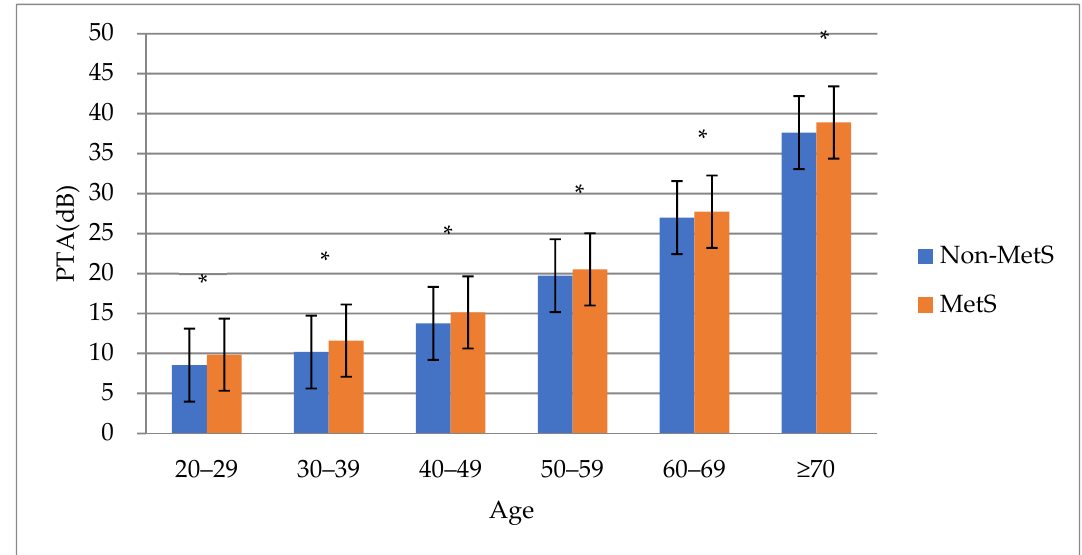
Figure 1. PTA threshold according to age. Abbreviations: MetS, metabolic syndrome; Non–MetS, without metabolic syndrome; PTA, pure tone audiometry. * Statistically significant. p < 0.05.